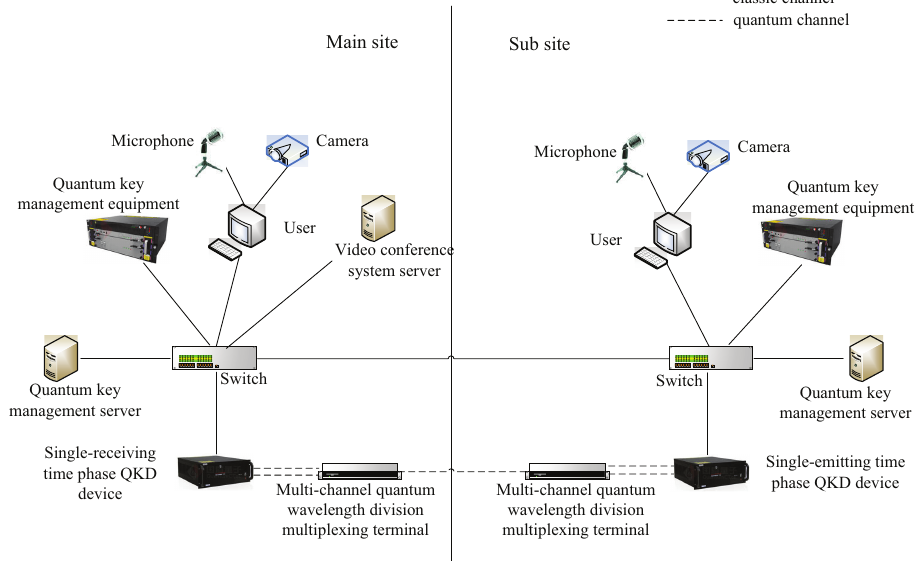
Figure 8. The video conference system network topology based on the quantum key.